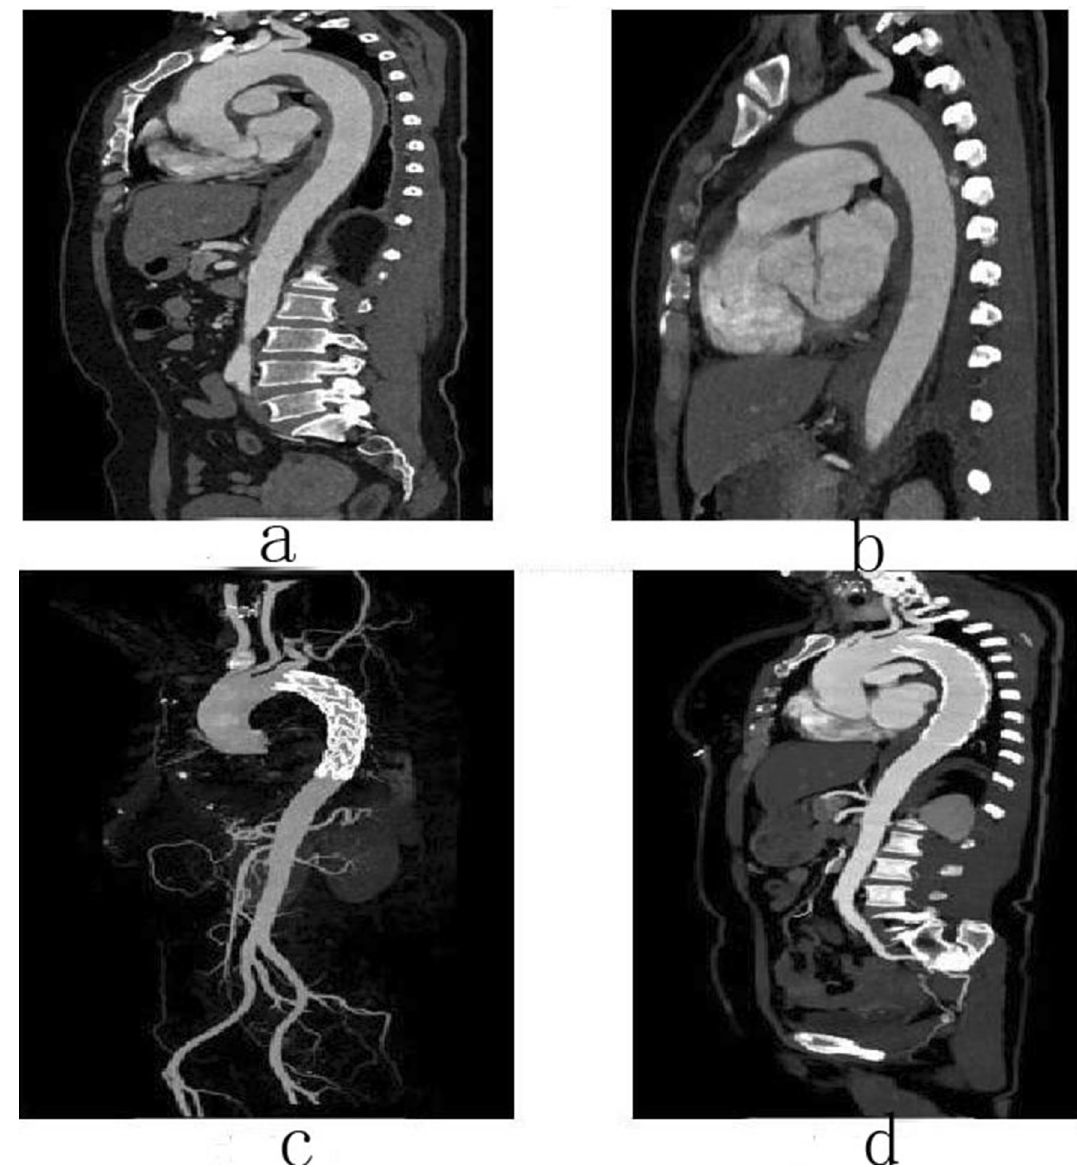
Figure 5. Female, 49 years old, admitted to hospital for “sudden tearing pain in low back for 48 h”, Diagnosis: Stanford type B aortic dissection; Treatment: IMH TEVAR treatment. CTA of the patient in different